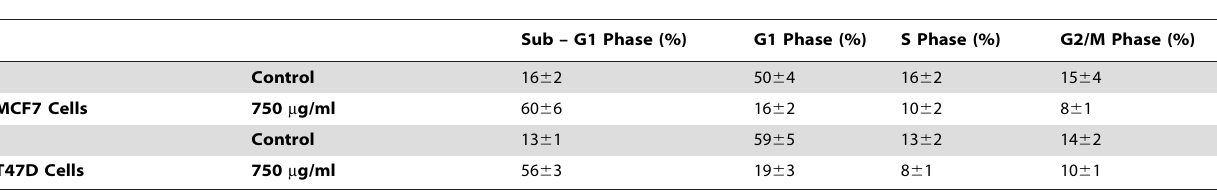
Table 1. The effect of BP-C1 on cell cycle progression.